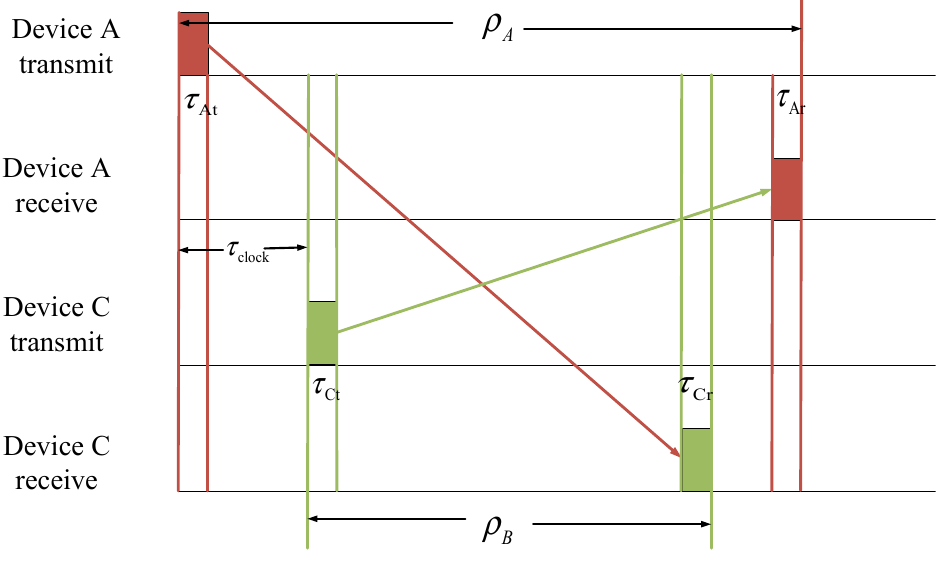
Figure 18. The dual one way